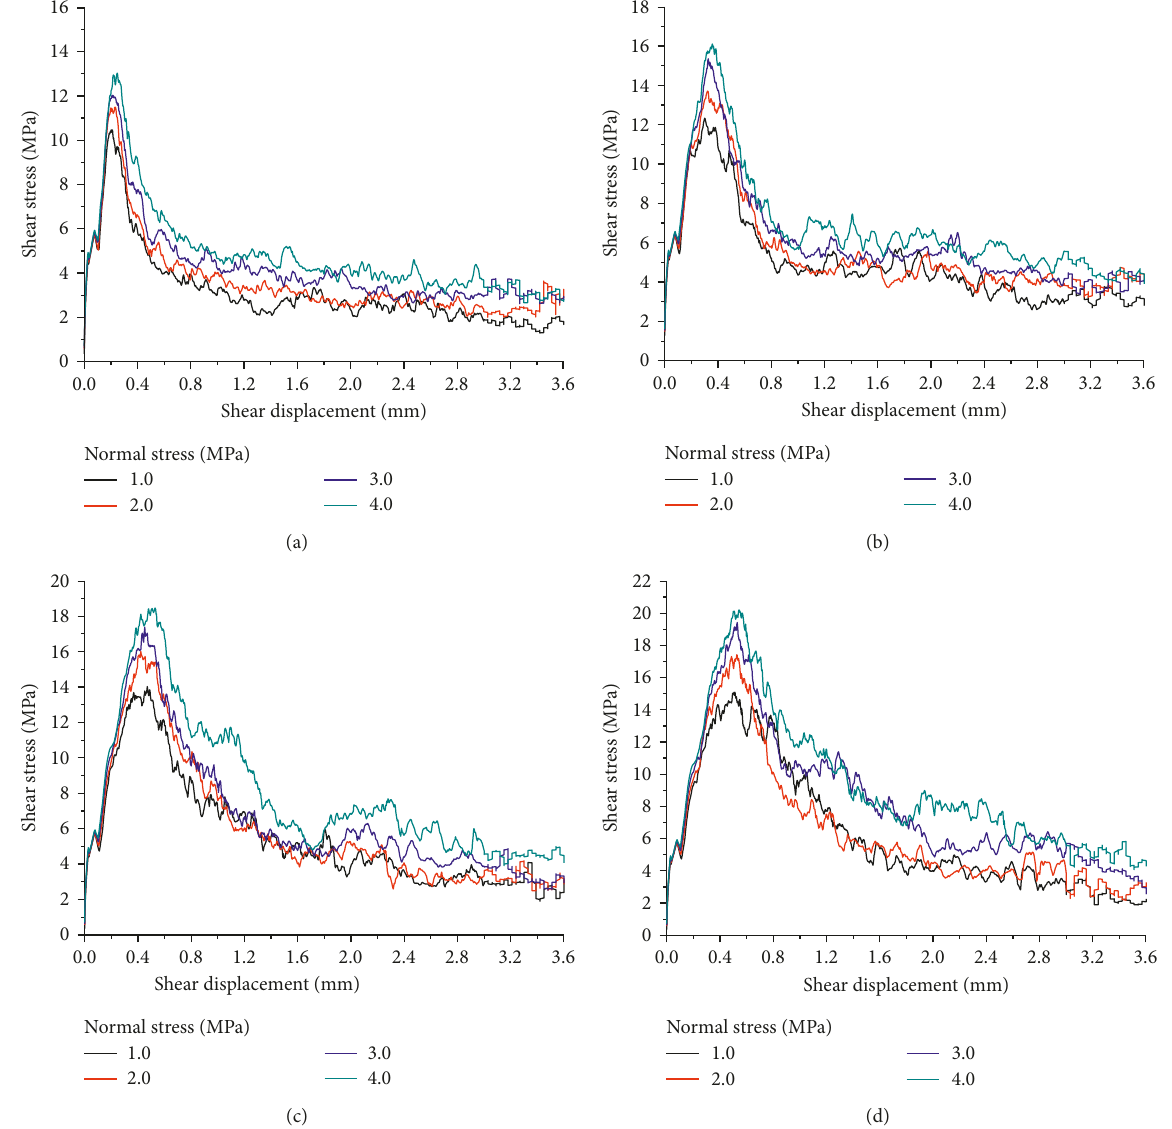
Figure 4: Shear curves for specimen with different bond strength ratios: bond strength ratios of (a) 0.25, (b) 0.5, (c) 0.75, and (d)